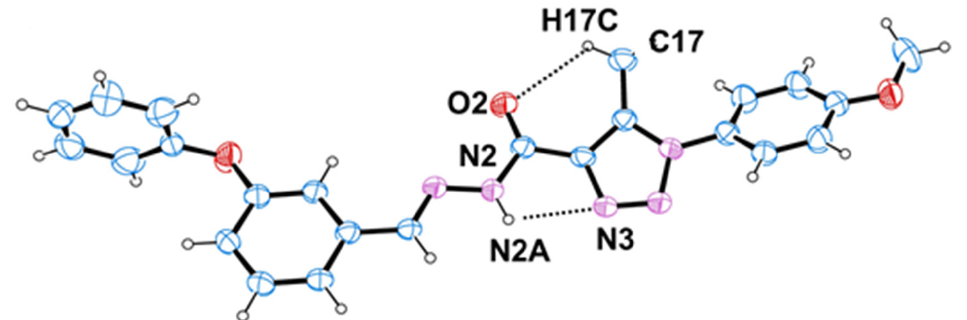
Figure 2. Intramolecular hydrogen bonding of 2 .